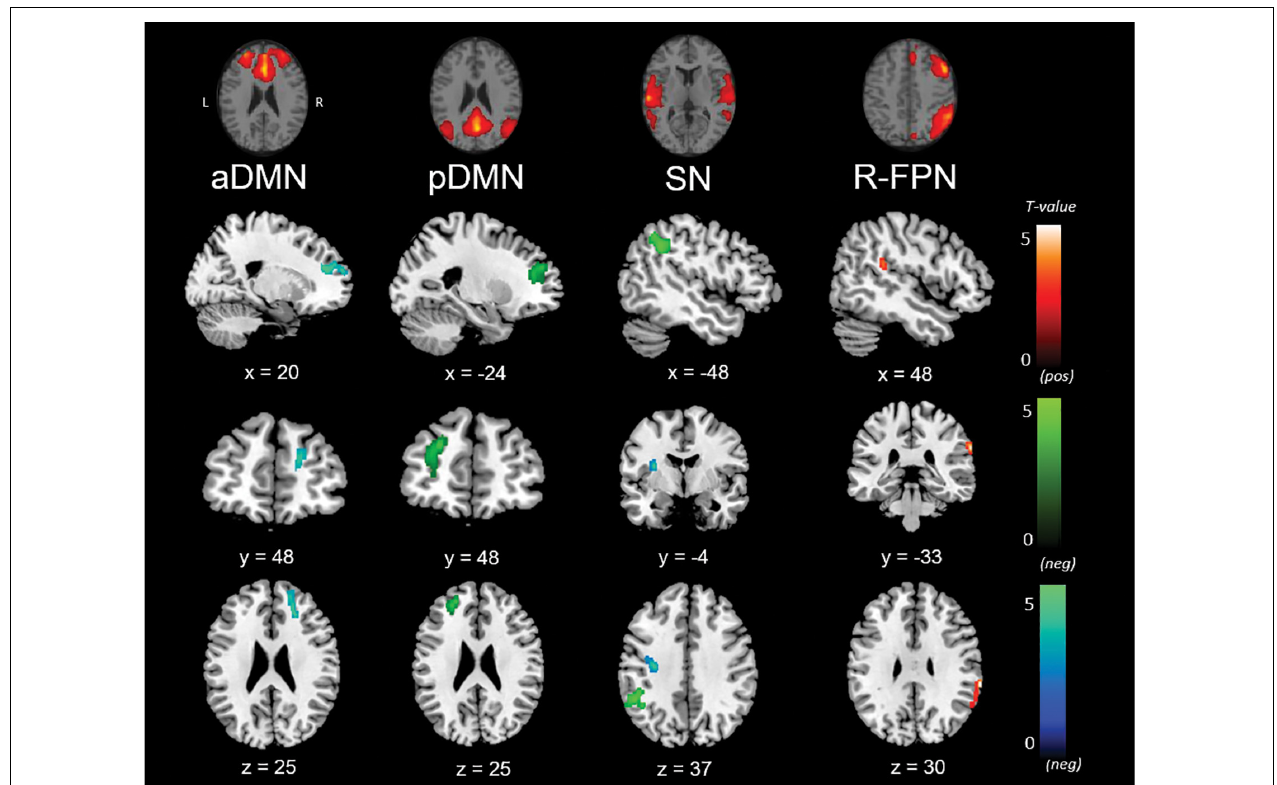
FIGURE 4 | Negative (Ek-60F, green; RMET, blue), and positive (Ek-60F, red) correlations between functional connectivity of the anterior default mode network (aDMN), posterior default mode network (pDMN), salience network (SN), right fronto-parietal network (r-FPN) and social cognition